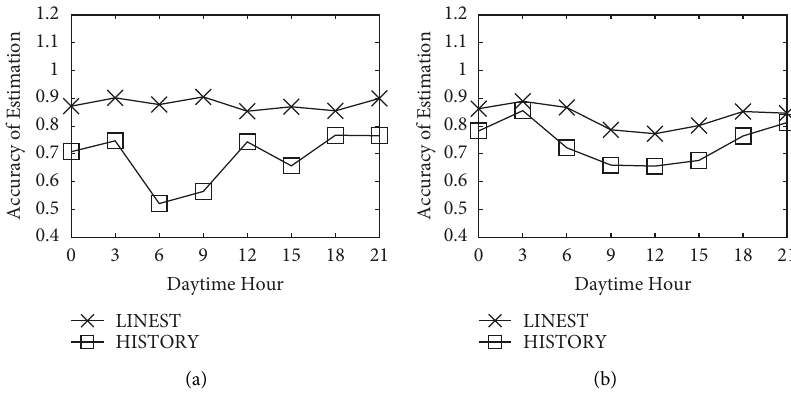
Figure 6: Regional traffic estimation. (a) Downtown. (b)